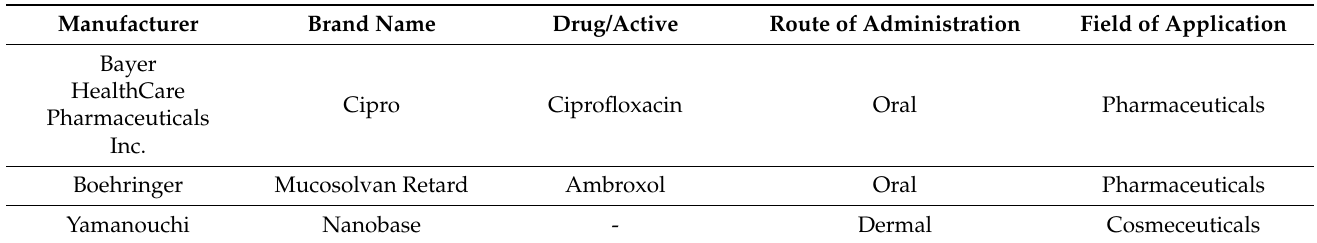
Table 4. SLN-based products in the